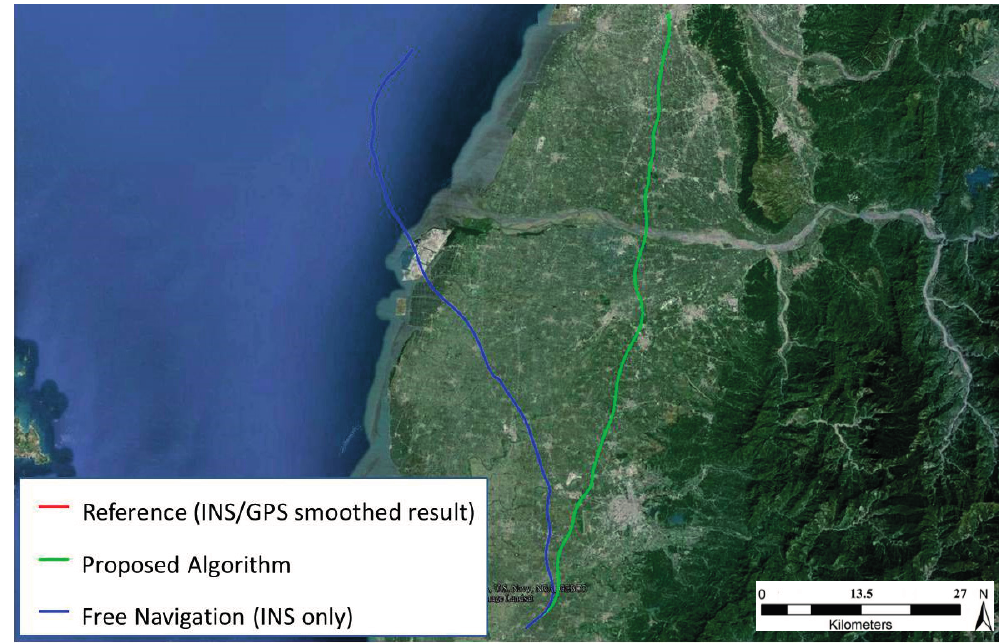
Figure 8. The trajectories of land test.